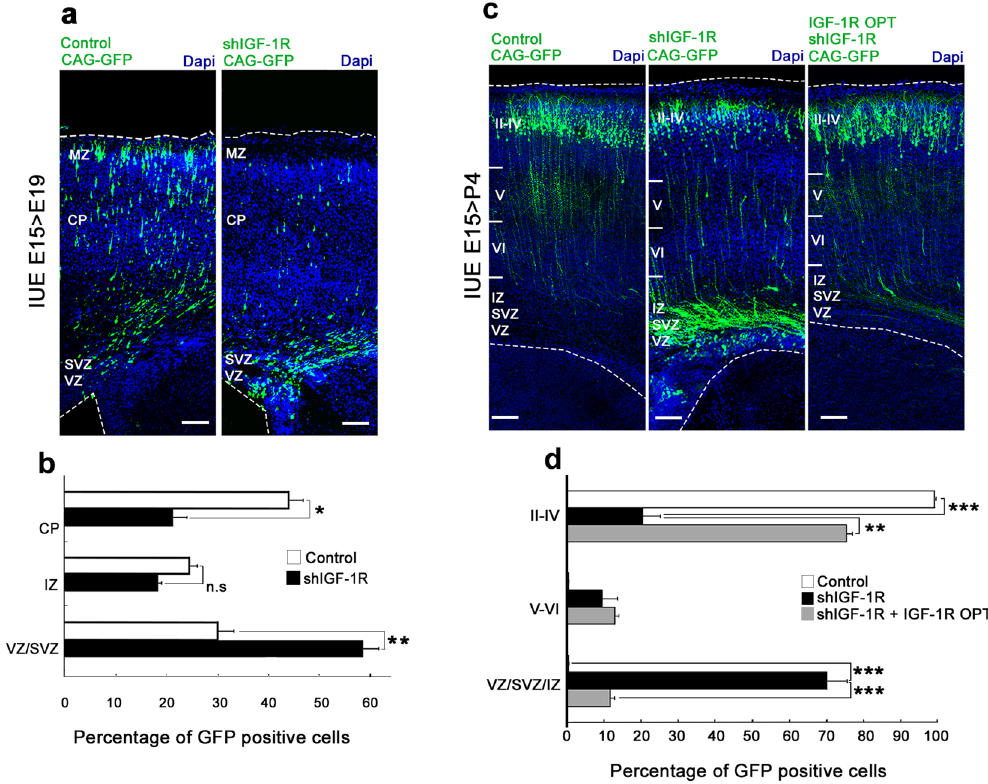
Figure 2. Expression of IGF-1R regulates neuronal migration. ( a ) Brains were electroporated with shRNA- IGF-1R (shIGF-1R/CAG-GFP) (right) or control shRNA/CAG-GFP (control-left), at E15 and analyzed at E19. Few GFP positive cells were located in the cortical plate (CP) and the marginal zone (MZ) when IGF-1R expression was knocked down compared to control. Calibration bar = 50 μ m. ( b ) Quantification of the distribution of GFP-positive cells in CP, intermedial zone (IZ) and ventricular/subventricular zones (VZ/SVZ) as indicated in A. Student’s t test * p ≤ 0.05; ** p ≤ 0.01; ns = not significant. ( c ) Brains were electroporated at E15 with shIGF-1R/CAG-GFP (middle), control shRNA/CAG-GFP (left) or co-electroporated with shIGF-1R/ CAG-GFP plus cDNA coding for IGF-1R OPT and analyzed at P4. A few GFP positive cells are located in layers V-VI and noticeably fewer GFP positive cells are found in layers II-IV in the IGF-1R suppressed brain compared to the control. In contrast, an important accumulation of GFP positive cells was observed at the (VZ/SVZ/IZ) zones in the shRNA-IGF-1R brain. Note that co-transfection with cDNA coding for IGF-1R OPT (shRNA- refractive cDNA that will express the IGF-1R even in the presence of shRNA- IGF-1R ) rescued the morphology. Calibration bar = 100 μ m. ( d ) Quantification of the distribution of GFP positive neurons in VZ/SVZ/IZ, layers II-IV, V and VI as in c. Post hoc Turkey’s ANOVA ** p ≤ 0.01 *** p ≤ 0.0001. n = 3 independent experiments. An average of 300 cells ( a , b ) or 500 cells ( c , d ) were scored for each